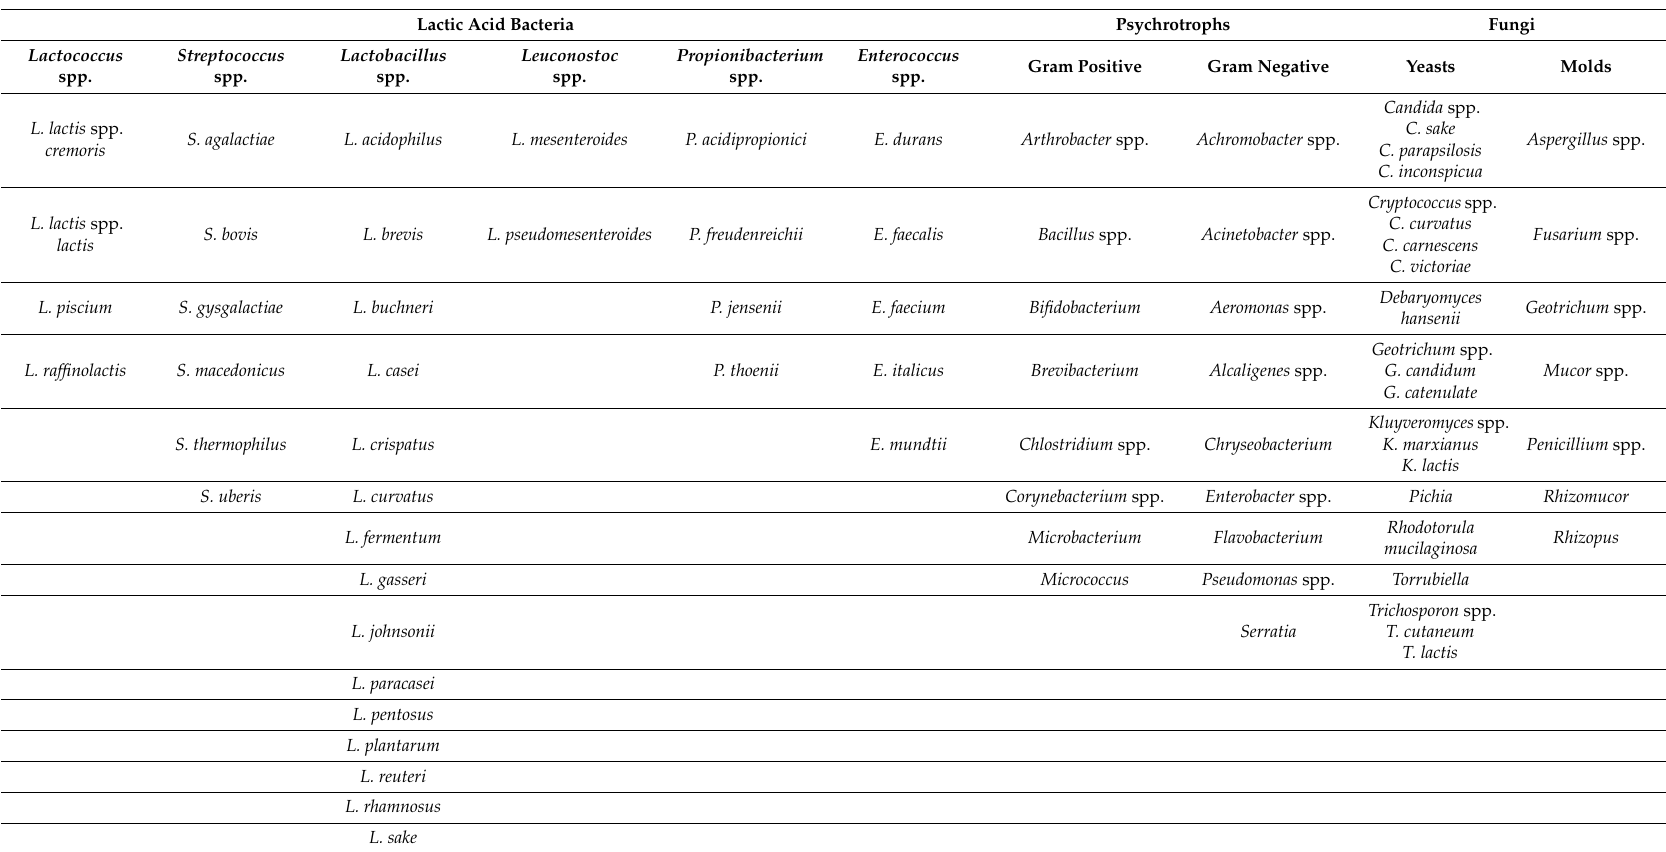
Table 1. Spoilage microorganisms in raw milk 1